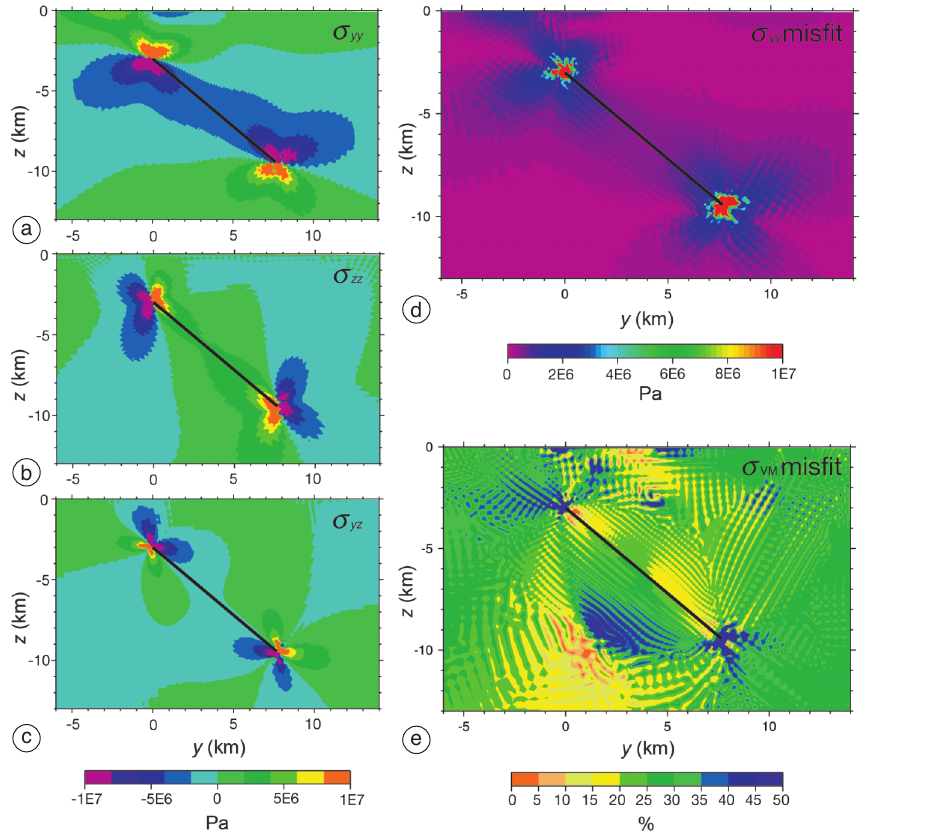
Fig. 5a-e. a) σ yy , b) σ zz , and c) σ yz components of the FEM stress tensor. d) Absolute difference between the finite-element and the analytical σ yy . e) Relative difference between the numerical and the analytical scalar equivalent Von Mises